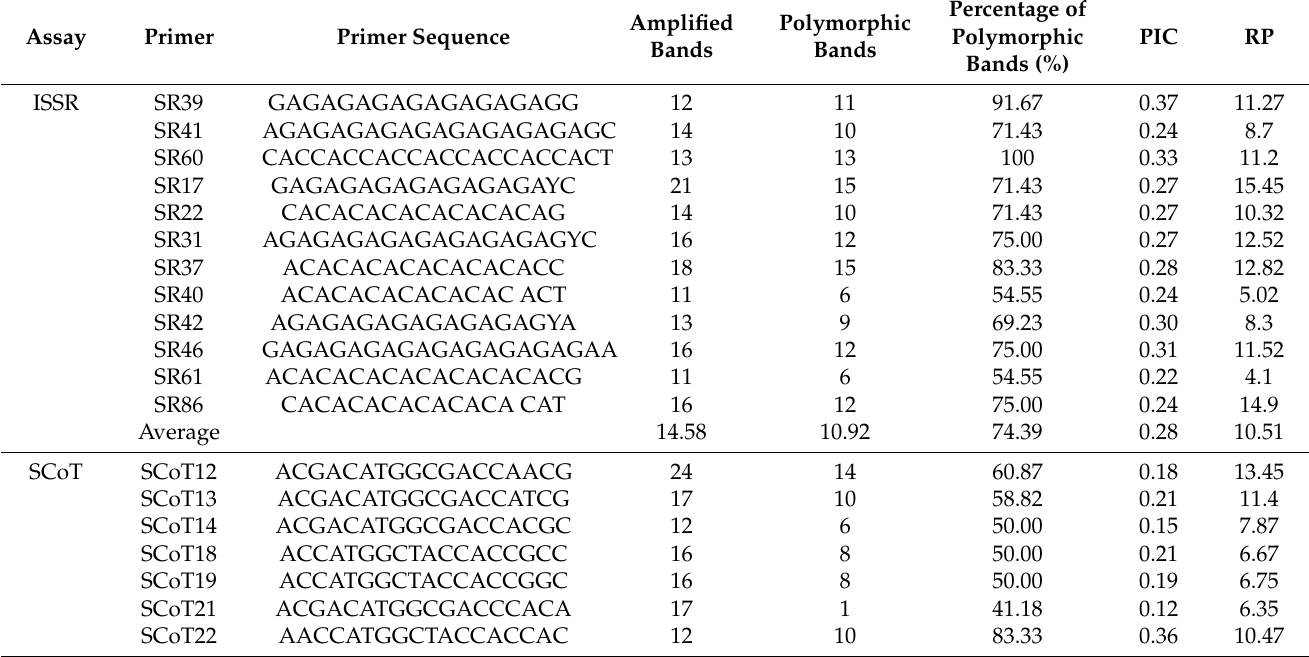
Table 4. Characteristics of ISSR and SCoT primers used to assess the genetic diversity of the analysed B. graminis f. sp. avenae